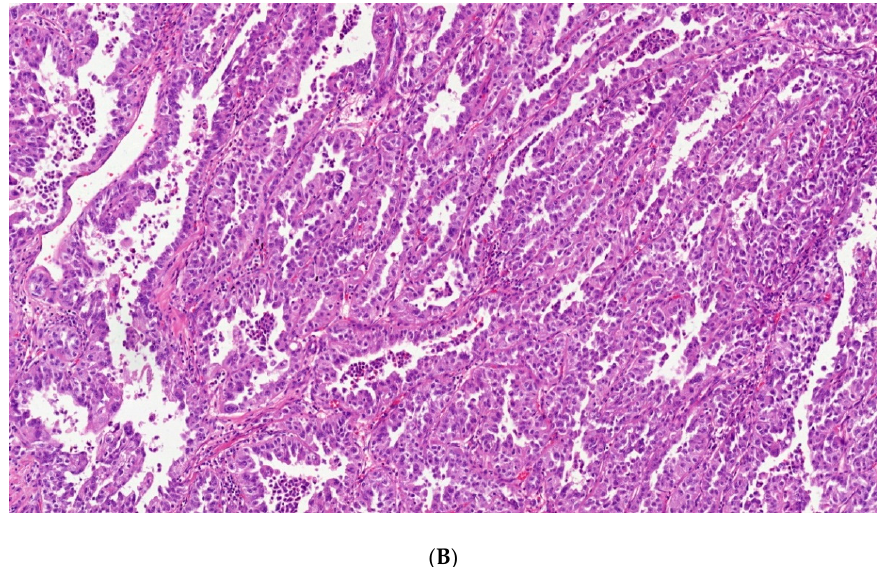
Figure 3. FH-deficient RCC: deep red macronucleoli can be prominent ( A ), however in some cases it is not easy to detect them ( B ). 4× magnification.